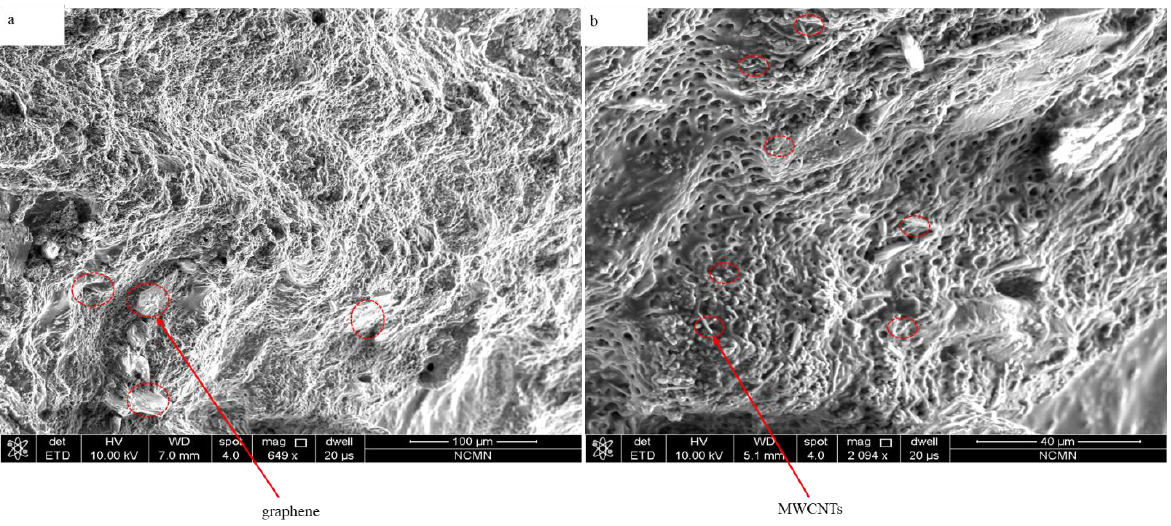
Figure 5. SEM images of hybrid hydrogel: ( a ) PAN/AM/graphene/CaCl 2 , and ( b ) PAN/AM/MWCNTs/CaCl 2 . MWCNTs/CaCl 2 .